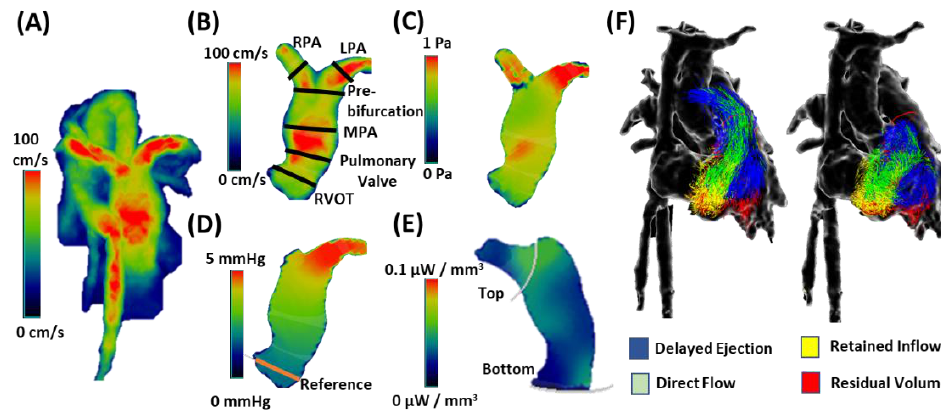
Figure 2. Post-processing of 4D-flow. First, 4D-flow velocity field (Vi, Vj, Vk) was corrected (Panel ( A )). Followed by data correction, the pulmonary artery was segmented for regional analysis. Several analysis planes were placed at specific landmarks for blood hemodynamic assessment: right ventricular outflow tract (RVOT), pulmonary valve, main pulmonary artery (MPA), pre-bifurcation, right pulmonary artery (RPA), and left pulmonary artery (LPA). Panel ( B , C ) shows a sample of wall shear stress at peak systole. Pressure drop used the RVOT plane as reference location (Panel ( D )). Energy loss used a centerline to guide a top and a bottom plane (grey lines) to define the volume of interest, (Panel ( E )). Panel ( F ) illustrates a sample of ventricular flow analysis distribution components.